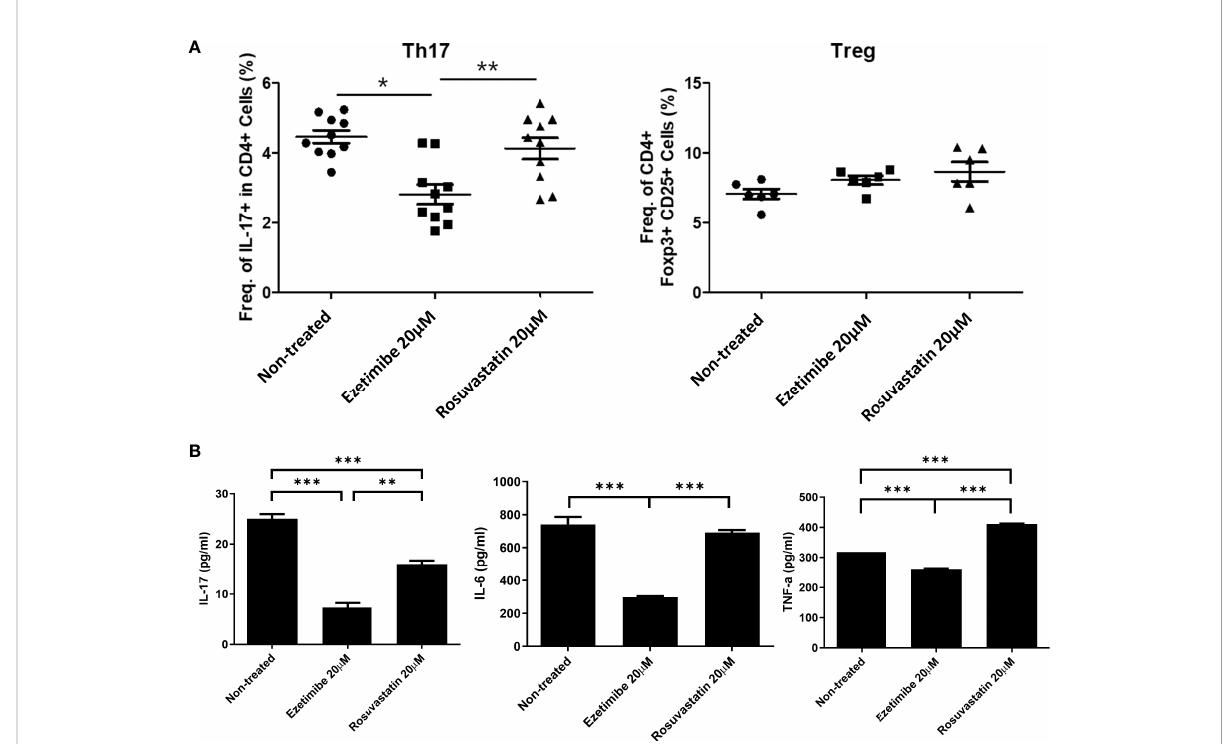
FIGURE 5 Effects of ezetimibe in PBMCs from AS patients. (A) Numbers of Th17 and Treg cells among PBMCs from AS patients, measured by fl ow cytometry. (B) Concentrations of IL-17, IL-6, and TNF- a in culture supernatants, measured by ELISA. Values are means ± SEMs of three independent experiments. *p < 0.05, **p < 0.01, ***p <